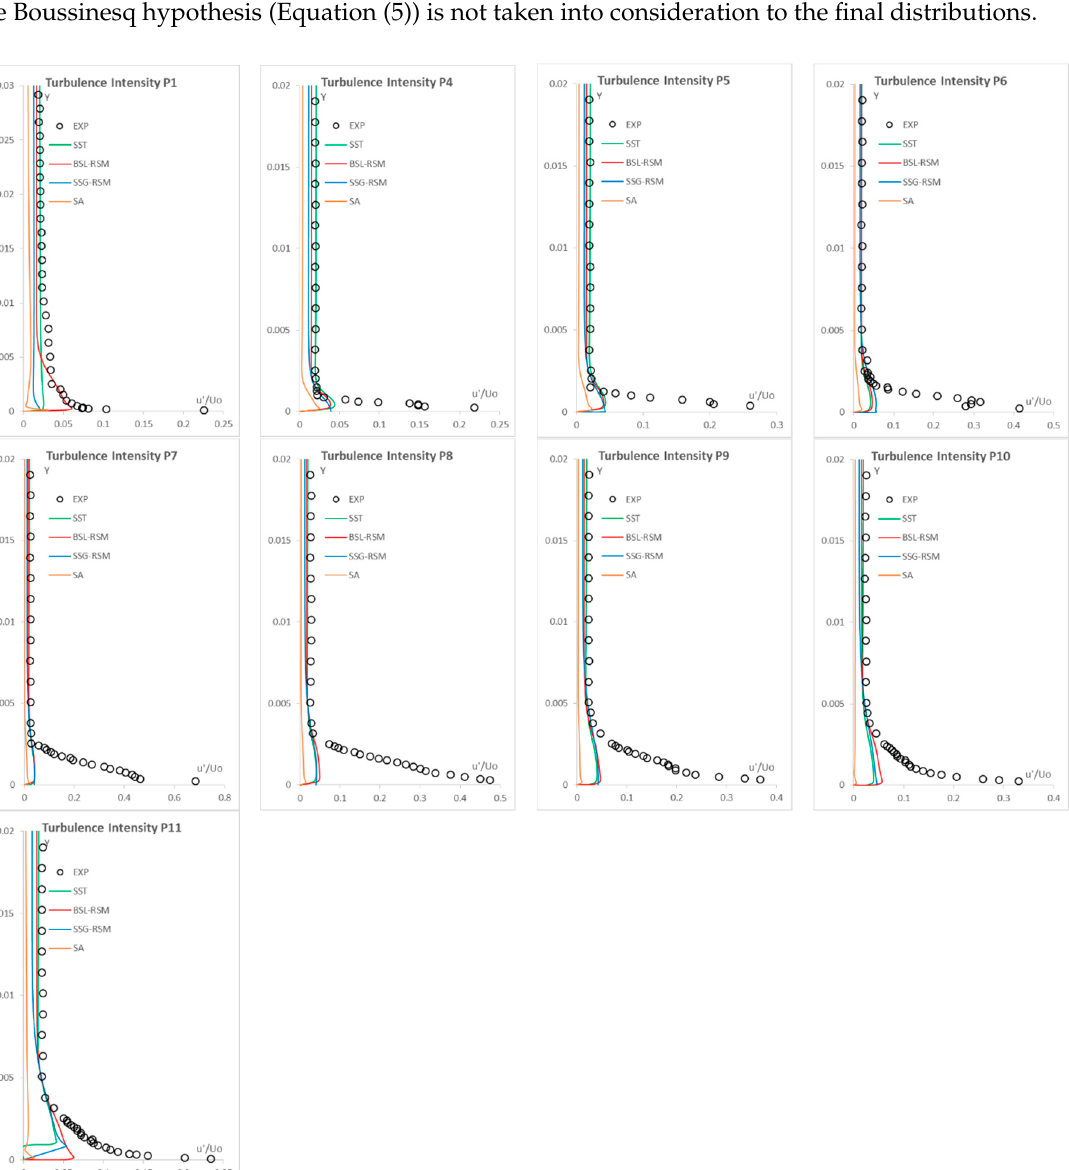
Figure 6. Turbulence intensity distributions on the DCA pressure side (no experimental data available for Stations P2 and P3).